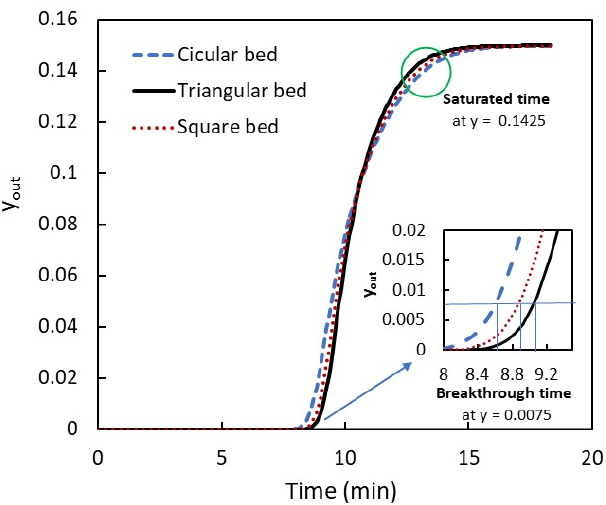
Figure 5. Carbon dioxide molar fraction at bed exit during the adsorption process (y in = 0.15).